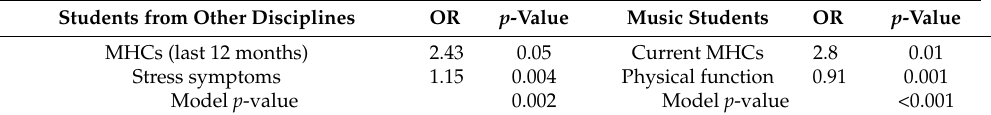
Table 5. Multivariate longitudinal analysis of risk factors for developing MHCs (prediction model). Students from Other Disciplines